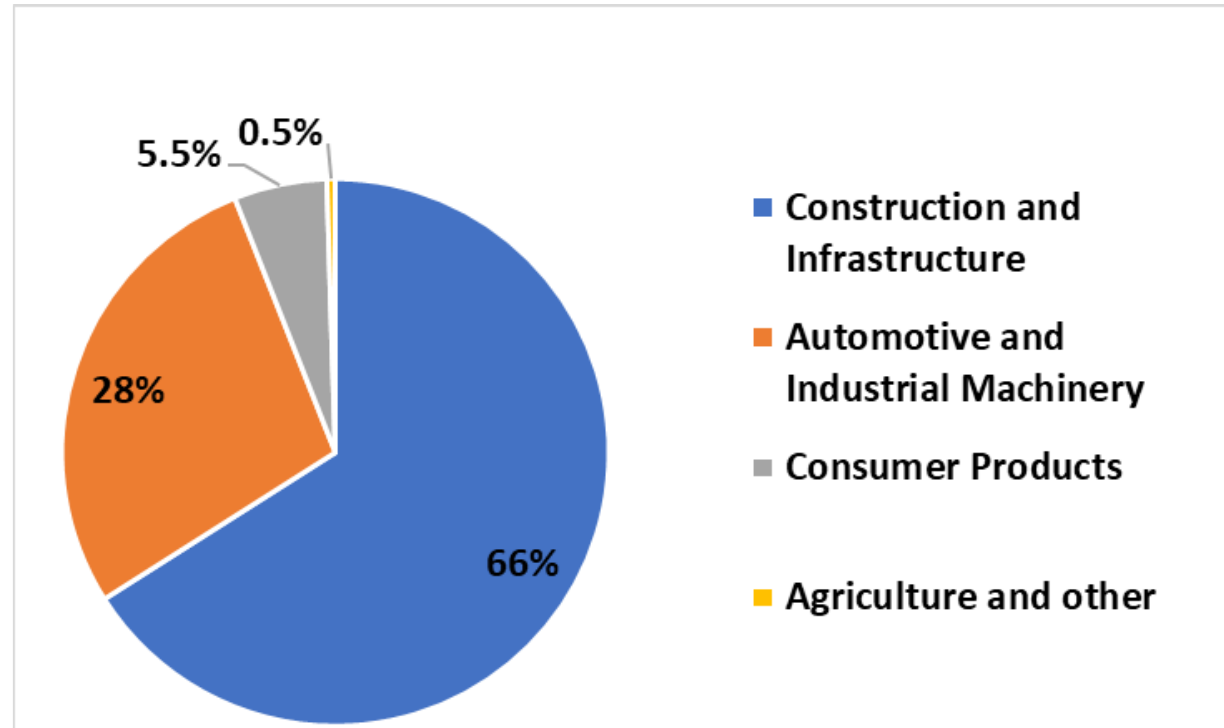
Figure 5. Zinc end use by applications in 2018, figure prepared based on data taken from [50,51].